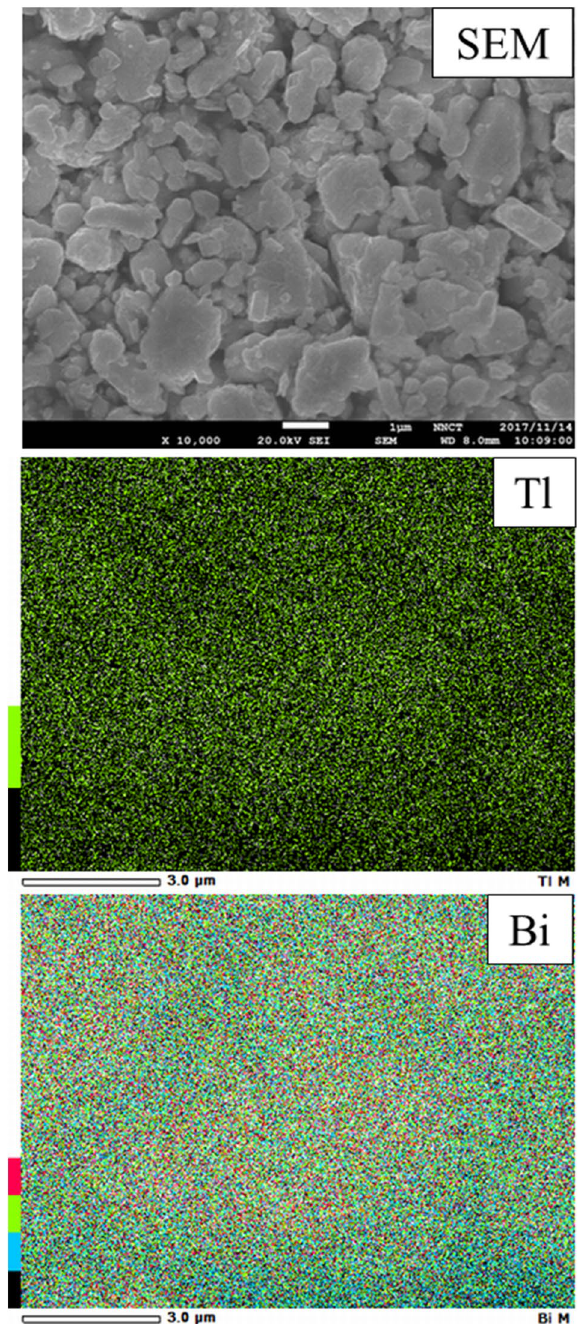
Figure 12. SEM image and EDS elemental mapping images of the Tl 2 O 3 ‒ 95 wt% Bi 2 O 3 composite